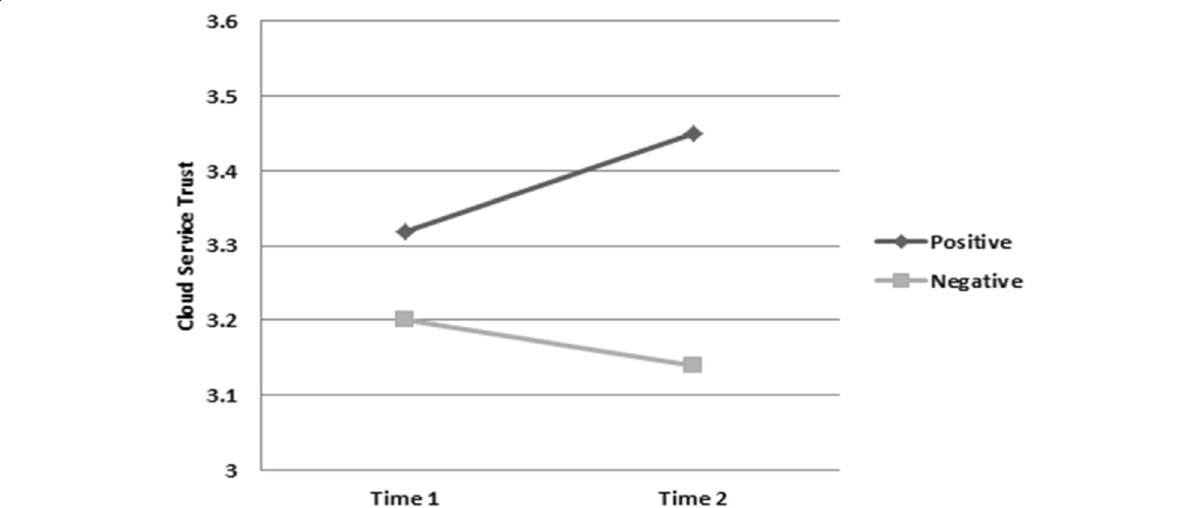
Fig. 6 Cloud Service Trust means by condition at Time 1 and Time 2. The figure shows the difference in overall trust in the cloud service between time 1 prior to exposure to the label and time 2 after exposure to the label. As shown, the positive label increased trust in the cloud service, whereas exposure to the negative label reduced